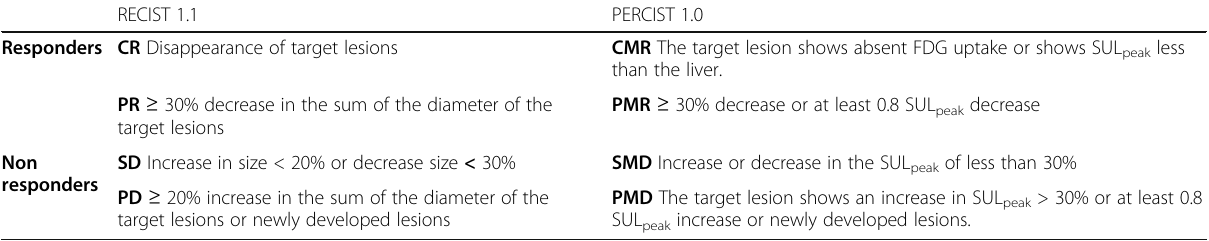
Table 1 RECIST 1.1 and PERCIST 1.0 criteria for therapeutic response evaluation [10] RECIST 1.1